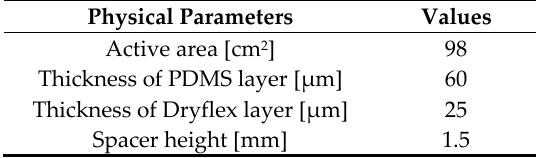
Figure 1. Schematic diagram of the design of fully stretchable triboelectric generator. Table 1. Dimensions of the fully film casted and stretchable TrEGs.